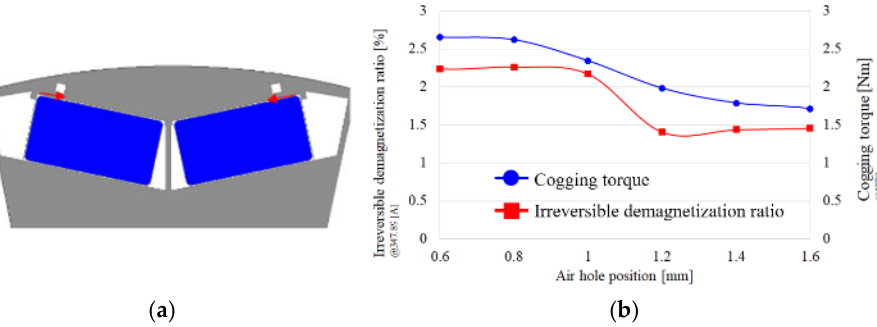
Figure 16. Air hole inserted model and cogging torque and irreversible demagnetization graph: ( a ) air hole inserted model; ( b ) cogging torque and irreversible demagnetization graph.